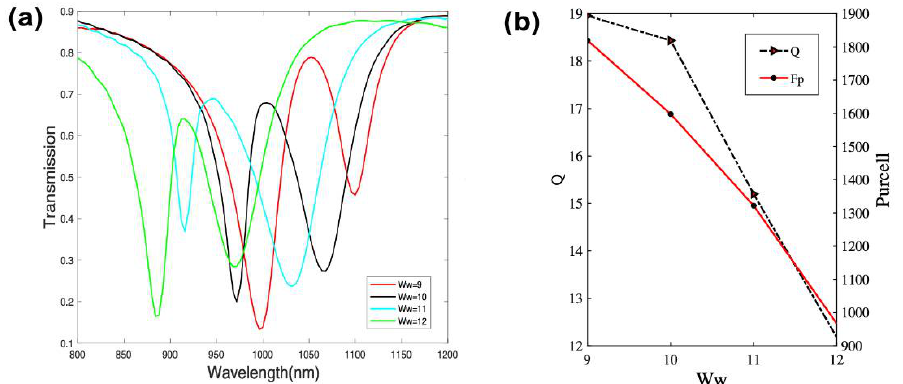
Figure 6. The transmission spectrum ( a ) and Q/Purcell factors ( b ) corresponding to varying (cid:1849) (cid:3050)